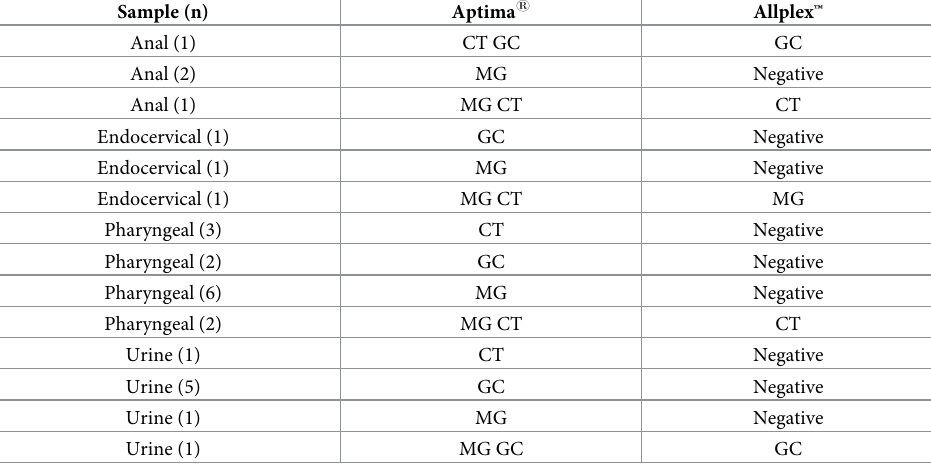
Table 5. Discordant results between Aptima 1 and Allplex ™ assays regarding the detection of C . trachomatis , M . genitalium and N . gonorrhoeae